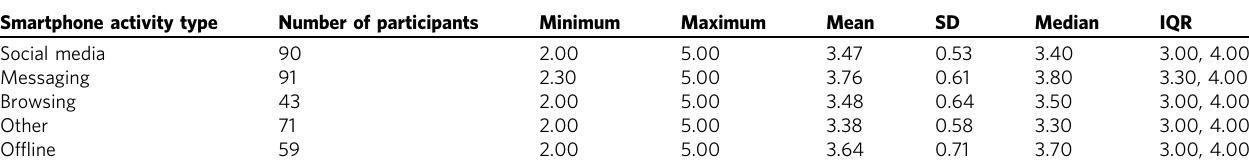
Table 1 Descriptives of feeling scores per smartphone activity